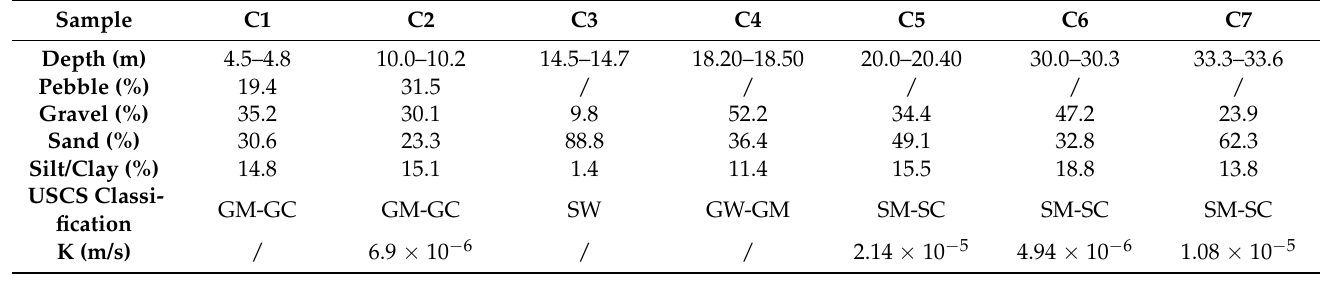
Table 3. Summary of the geotechnical parameters of the borehole. C1, C2, C3 and C4 indicate the samples at various depths on which the tests were performed. K = permeability coefficient determined by the Lefranc permeability test.